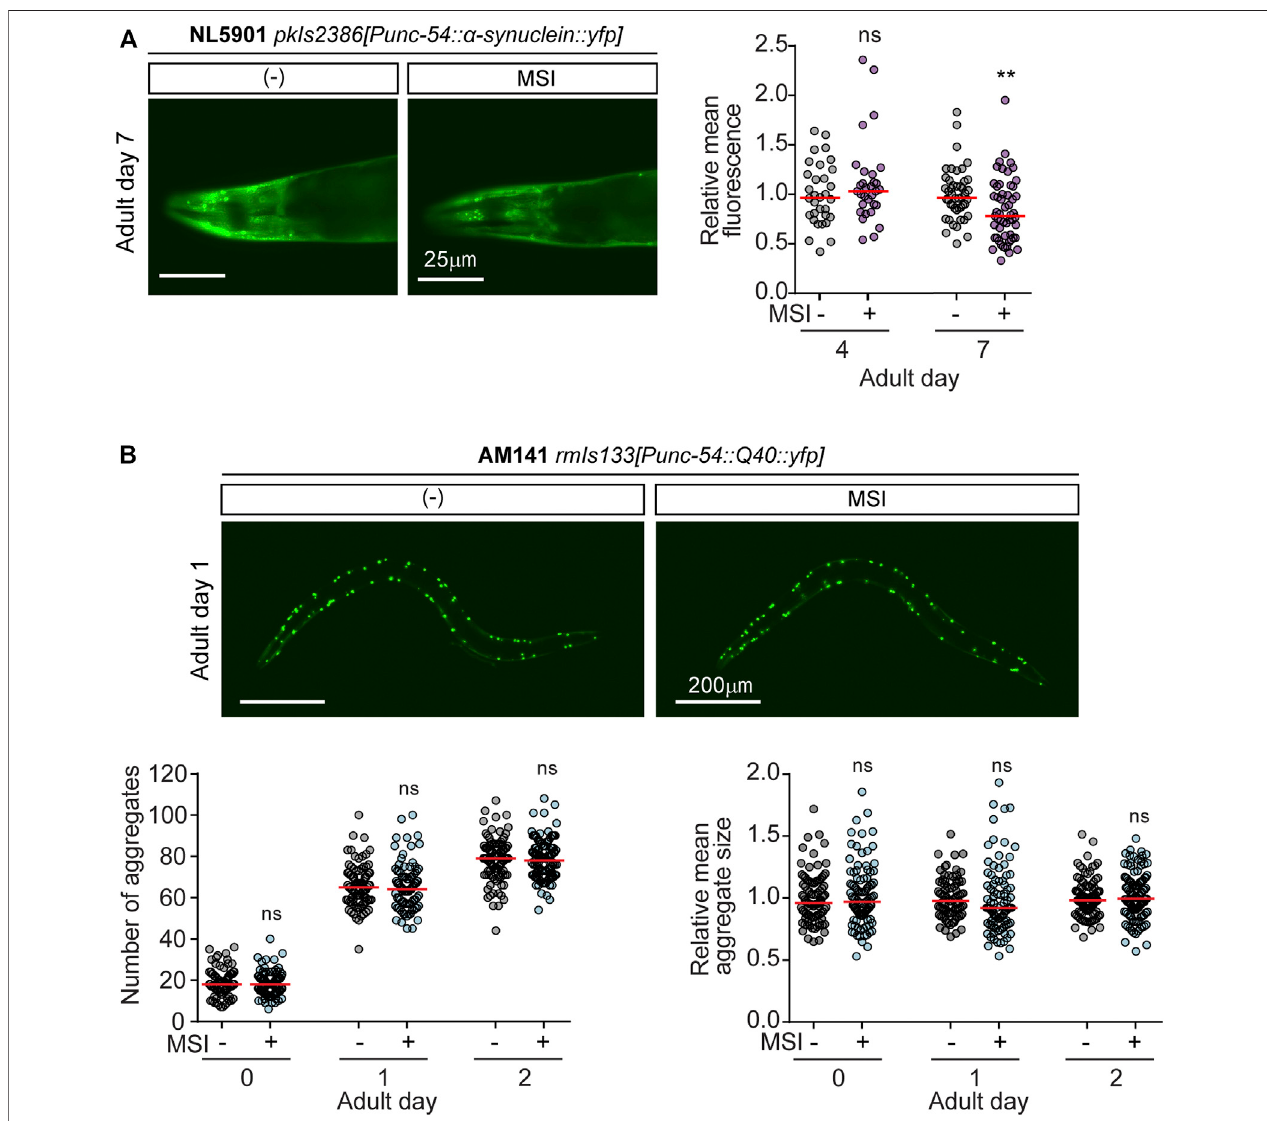
FIGURE 4 | MSI effects on protein aggregation in C. elegans models of ND. (A) . Quanti fi cation of α -synuclein expression levels upon MSI treatment. Left: Representative fl uorescence images depicting α -syn::yfp in 7-day adultworms grown inthe absenceor presence of50 μ MMSI. Right:Relative fl uorescence intensity in the head area of the worm at different ages represented in a scatter-dot plot (line at the median). Each dot symbolizes one worm ( n = 30 – 60). Statistical analysis was performed by comparing differences between median values for 0 and 50 μ M MSI at each indicated stage (Mann-Whitney Rank Sum Test). Statistical symbols represent** p < 0.01andnsnotsigni fi cant. (B) Quanti fi cationofpoly-QaggregationuponMSItreatment.Top:Representative fl uorescenceimagesdepictingQ-40::YFP in 1-day adult worms grown in the absence or presence of 50 μ M MSI. Bottom: The number of aggregates per animal and their relative mean size at days 0, 1, and 2 of adulthoodwerequanti fi edusingImageJFIJIandrepresentedintheircorrespondingscatter-dotplot(lineatthemedian, n =60 – 80).Statisticalanalysiswasperformedby comparing differences between the median for 0 vs. 50 μ M MSI (Mann-Whitney Rank Sum Test, ns not signi fi